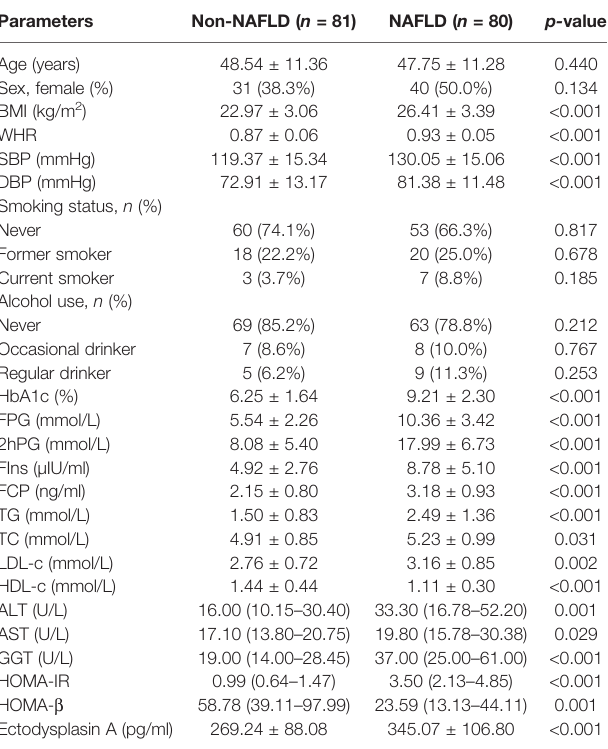
TABLE 2 | Clinical and biochemical characteristics in NAFLD and non-NAFLD groups.